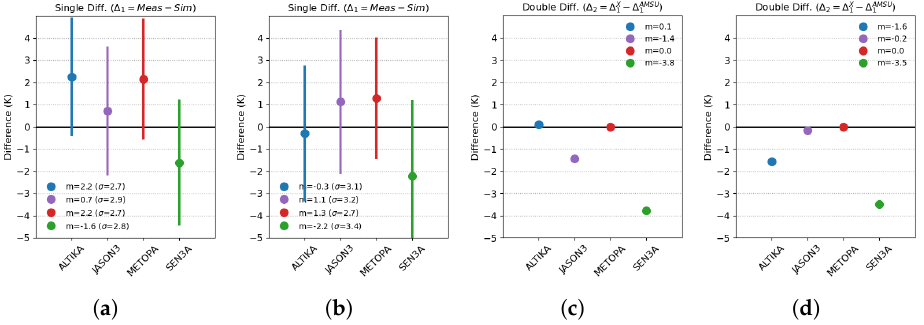
Figure 6. Mean Single (MES-SIM) and double difference for Altika, J3, Metop-A and S3A. ( a ) Single difference 23.8 Ghz channel; ( b ) Single difference Cloud Liquid Water Content (CLWC) channel; ( c ) Double difference 23.8 Ghz channel; ( d ) Double difference CLWC